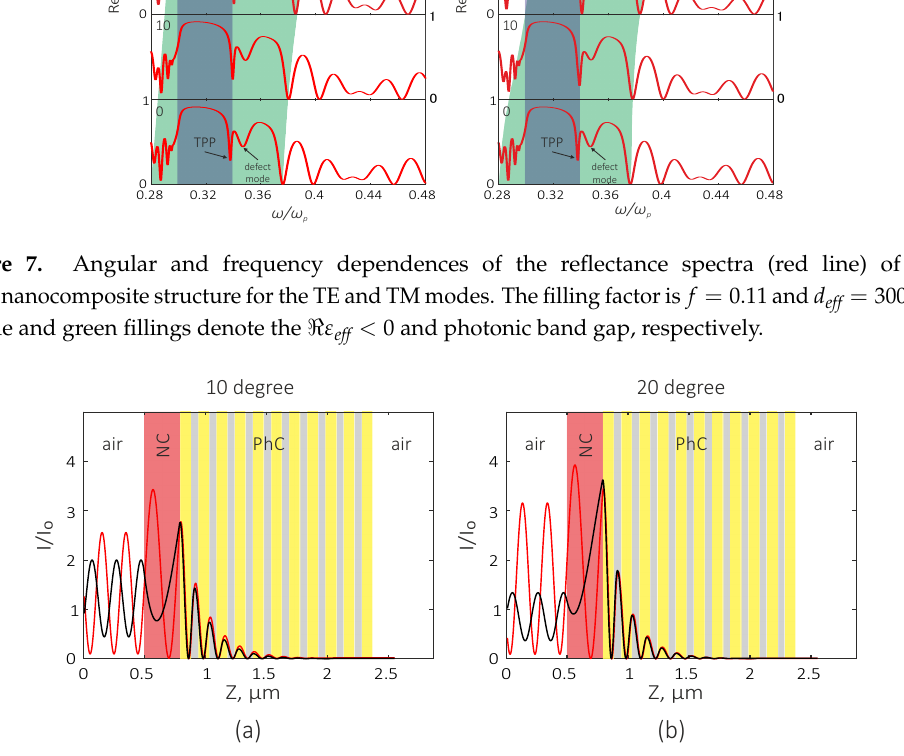
Figure 8. Schematic of a one-dimensional PhC (yellow - SiO 2 , grey - ZiO 2 ) conjugated with the nanocomposite layer (red) and field intensity distribution at oblique light incidence on the structure at the frequencies of TPP (black line) and defect mode (red line) normalized to the input intensity for the TM ( a ) and TE ( b ) waves. The nanocomposite layer thickness is d eff = 300 nm and f =